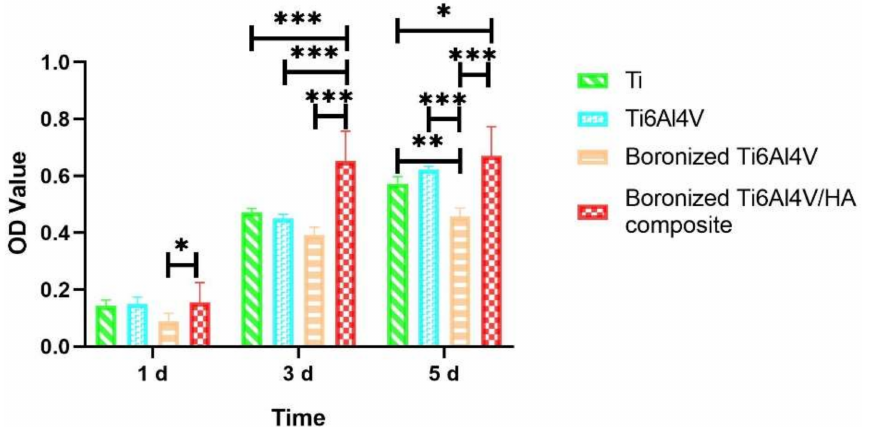
Figure 3. Cell proliferations on the different specimens after 1, 3, and 5 d of incubation determined by the MTT assays (* p < 0.05, ** p < 0.01, and *** p <